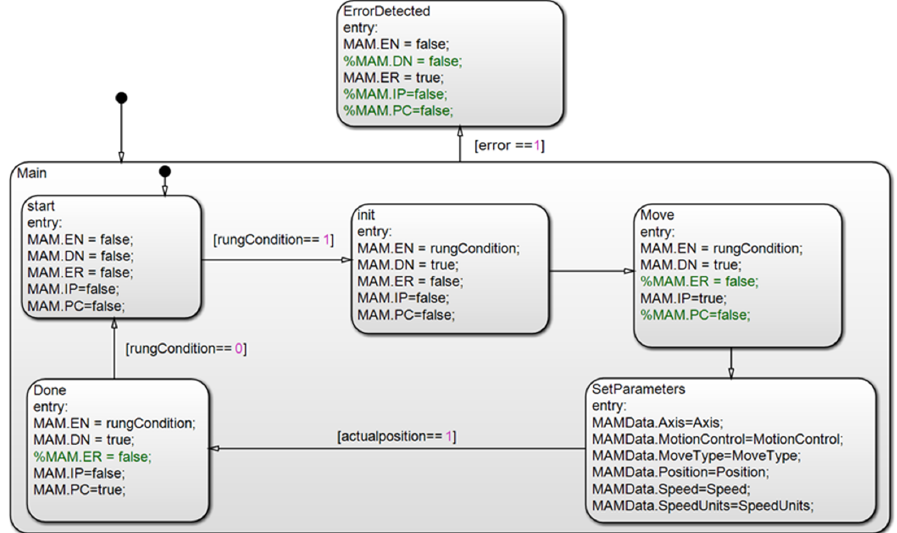
Figure 7. State Logic of the MAM model (function block model). Table 2. Motion Axis Move Status Bit Behaviour from [50].